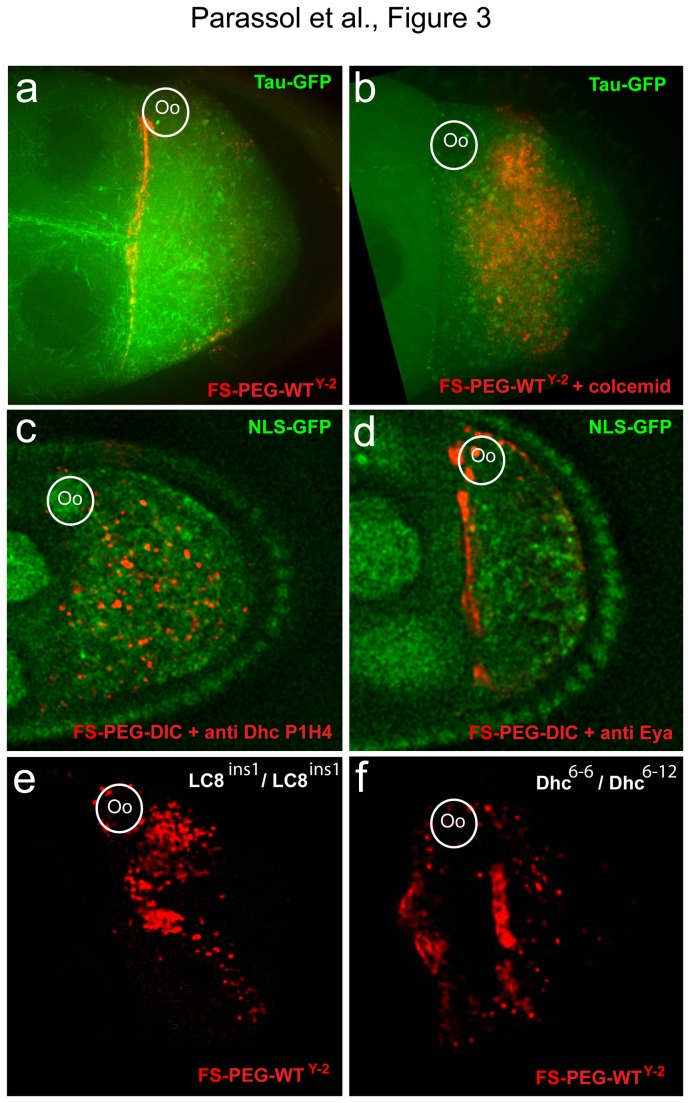
Transport of functionalized cargoes is MT and dynein dependent.(a, b) Tau-GFP oocyte. (a) FS-PEG-WTY-2 shows specific localization to the anterior pole. (b) FS-PEG-WTY-2 co-injected with colcemid fail to localize. (c) FS-PEG-WT co-injected with an anti-Dhc (P1H4) antibody fail to localize. (d) Co-injection of a control anti-Eya antibody does not affect FS-PEG-WT localization. (e) Localization of FS-PEG-WTY-2 into an LC8 ins1/LC8
ins1 hypomorphic mutant is perturbed. (f) Localization of FS-PEG-WTY-2 into a Dhc
6-6/Dhc
6-12 hypomorphic mutant is affected. Oocytes are shown 45 min after injection.